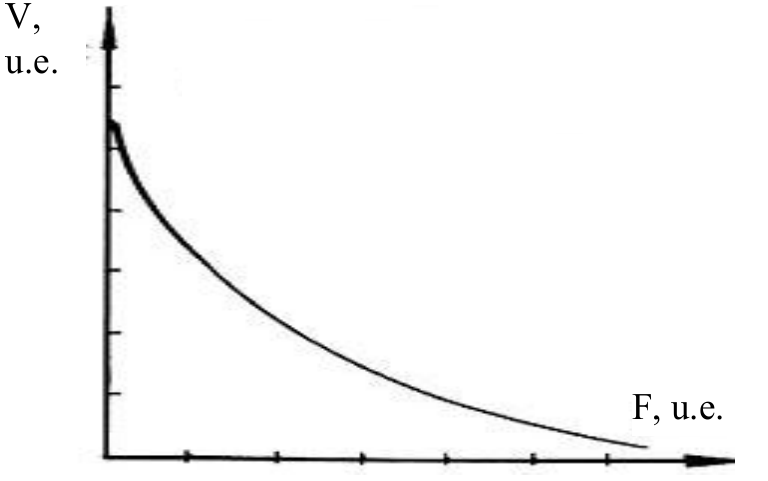
Fig. 1. Diagram “Power-speed” by Kh. Ralstone (1949), A. Hill and K. Ober (1950) [7,